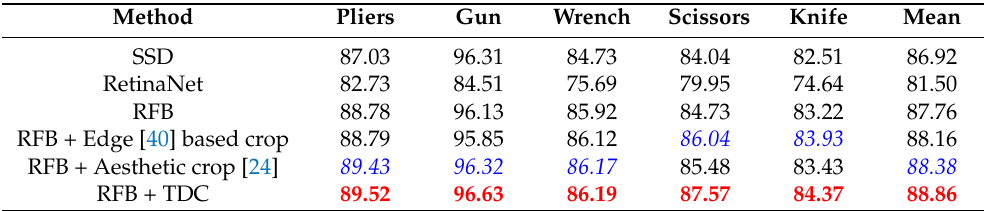
Table 3. Detection Average Precision on each class and mean Average Precision (mAP) on different models and test datasets. Red indicates the best and blue indicates the second best performance.